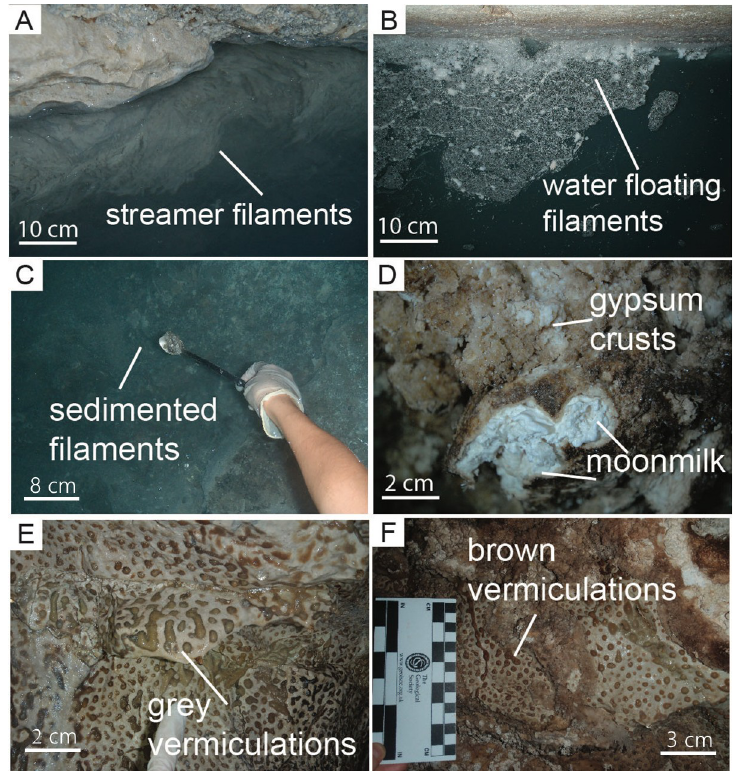
Fig 2. Field pictures of the most representative biofilms and deposits observed in Fetida Cave. A) Water filaments attached to the rock in the cave stream close to the entrance (named F-stream samples); B) Water filaments floating in the water in the inner zone of the cave (named F-float samples); C) Water biofilms sedimented on the water stream bed in the inner zone of the cave (named F-sed samples); D) Gypsum moonmilk deposits on the cave walls and ceilings (named M samples). It is surrounded by hard whitish gypsum crusts; E-F) Grey (named V-grey samples) and brown (named V-brown samples) vermiculations covering the cave walls and